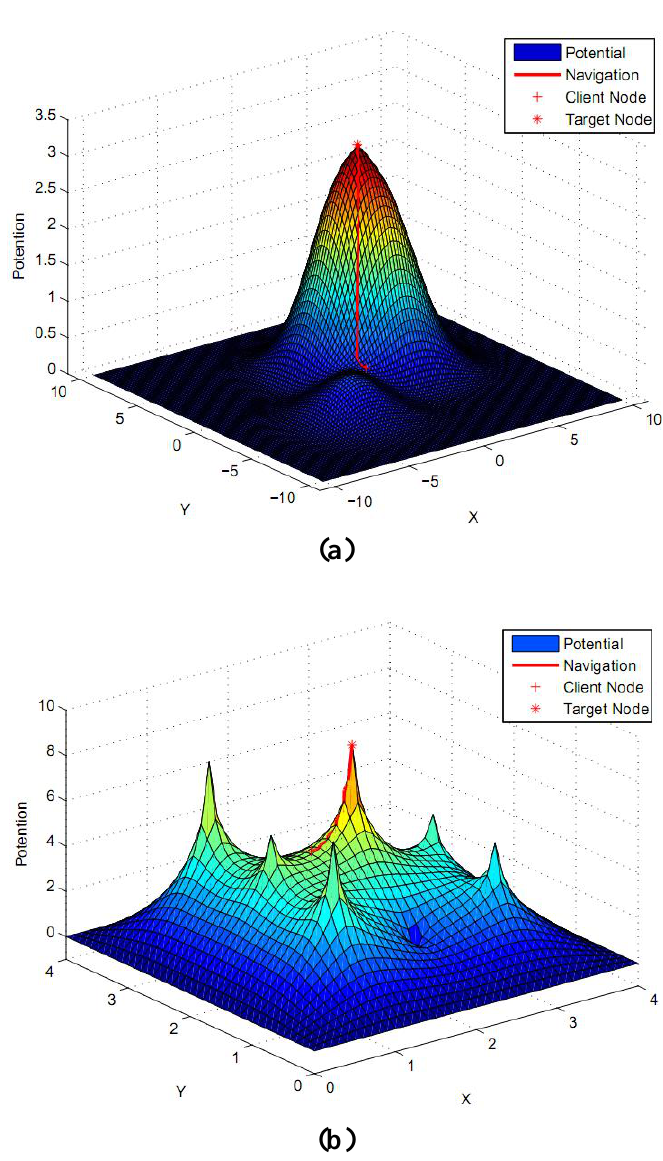
Figure 8. Multi-scale gradient descent of one user. (a) Guided to a region with high level; (b) Guided to a certain node with satisfied